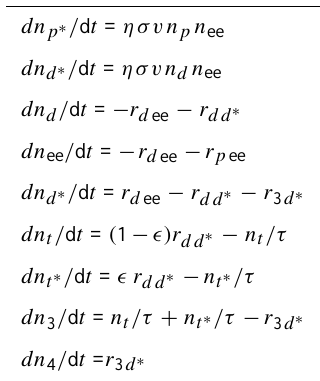
Table 1. The infinite-medium model rate